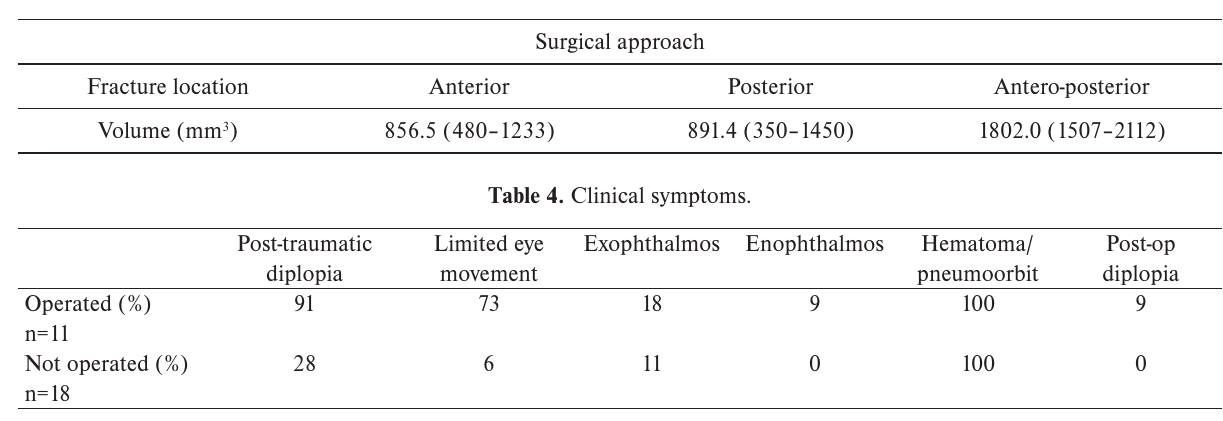
Table 3. Prolapsed volumes in blow-out fractures/surgical therapy.